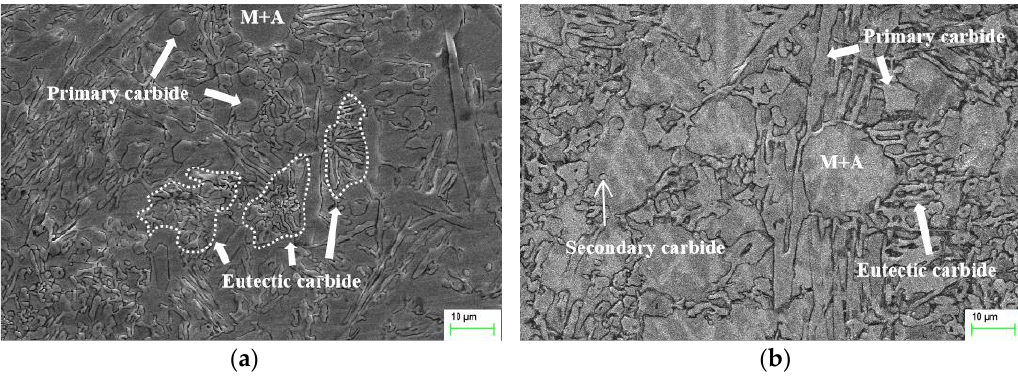
Figure 8. SEM micrographs of HCCI: ( a ) As-cast; ( b ) Quenching temperature 500 °C.